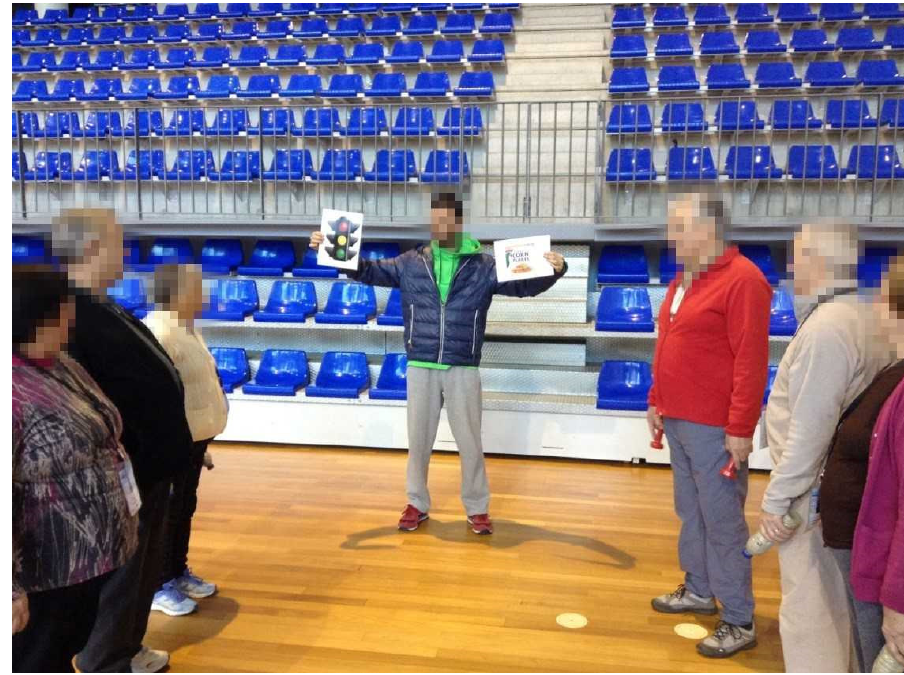
Figure 5. Traffic light system (group discussion) during walking exercise: green color—best food choices; yellow color—choose carefully; red color—foods to avoid.